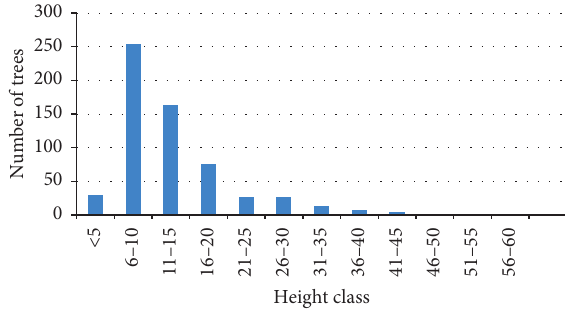
Figure 3: Height class distribution of